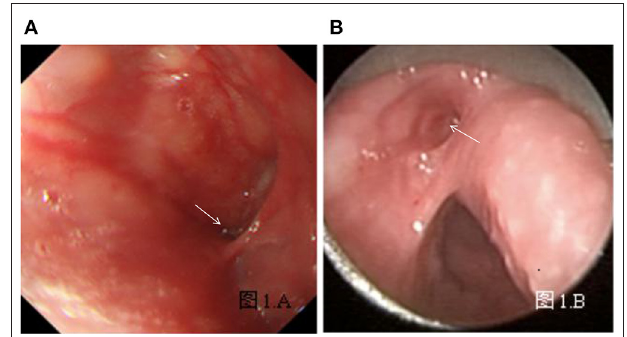
FIGURE 1 | (A) Left internal opening of CPSF and Betz folds using gastroscopy under local anesthesia. (B) Left internal opening of CPSF, Betz folds, and esophageal entrance using support laryngoscopy under general anesthesia. The arrow indicates the internal opening of